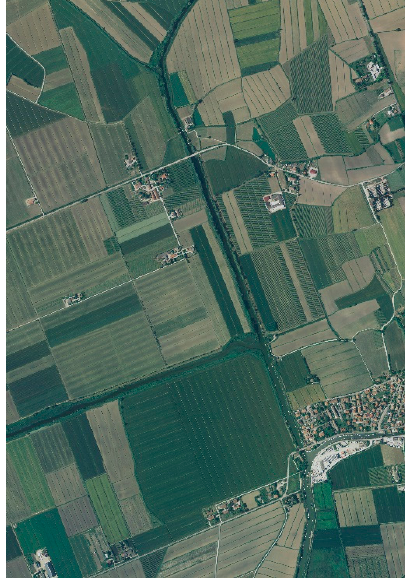
Figure 4. A sample of RGB Ortho-imagery depicting the area N of Aquileia.